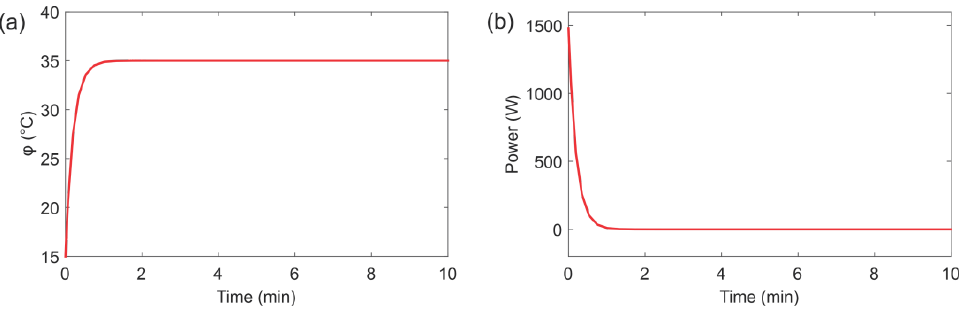
Figure 9. Hot water recirculation system response. ( a ) temperature sensor output, ( b ) temperature controller action.